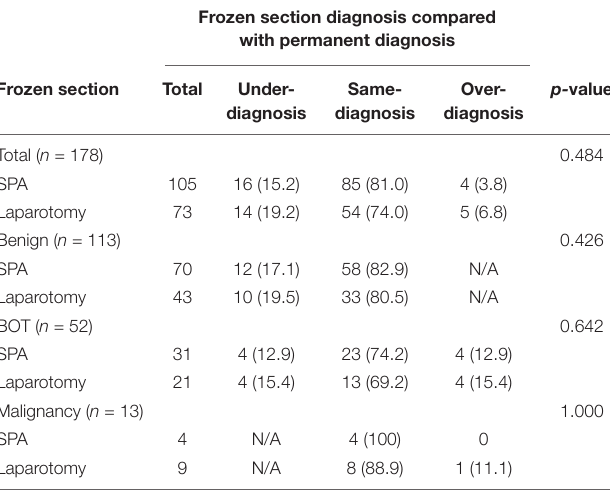
TABLE 4 | Tumor characteristics of the patients diagnosed with above borderline malignancy and concordance between the two pathological findings.